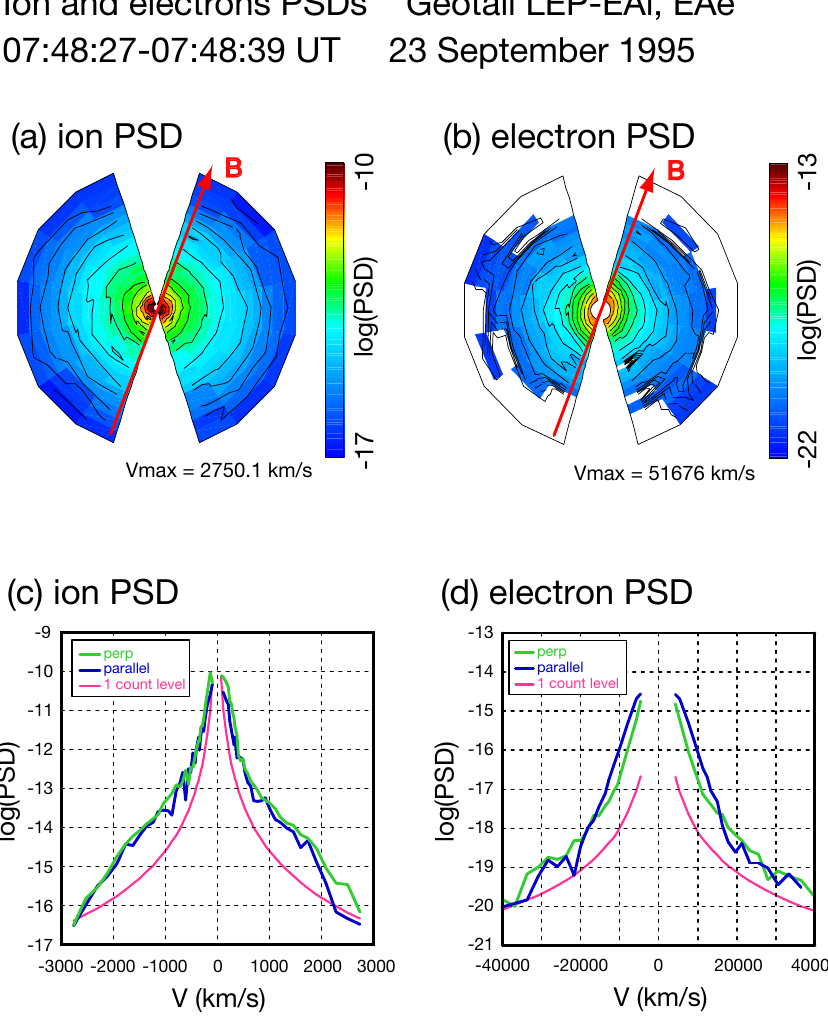
Fig. 7. Phase space densities of ions and electrons between 07:48:27–07:48:39 UT on 23 September 1995 in a similar format to Fig. 2.